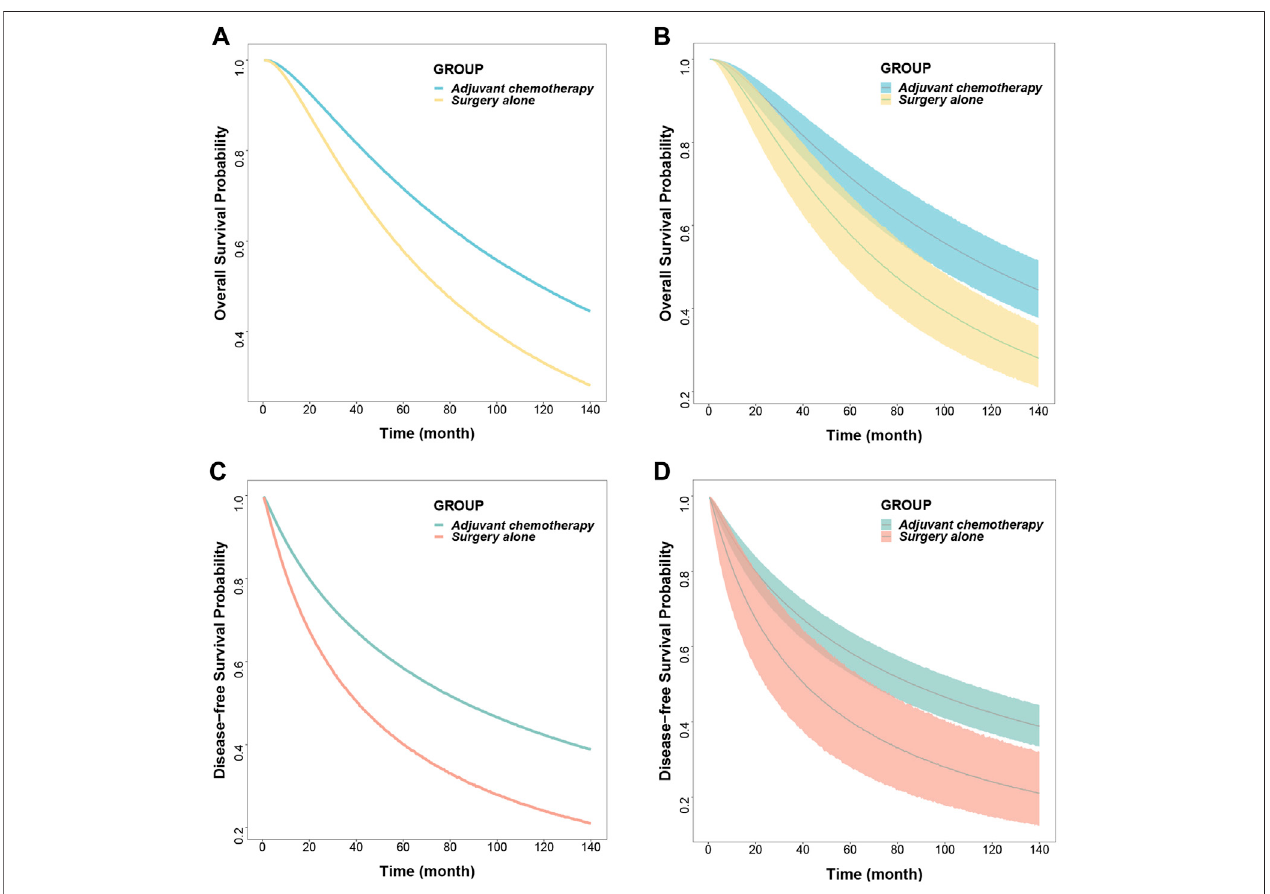
TABLE 3 | The predicted typical time course with 95% con fi dence interval of OS and DFS model.